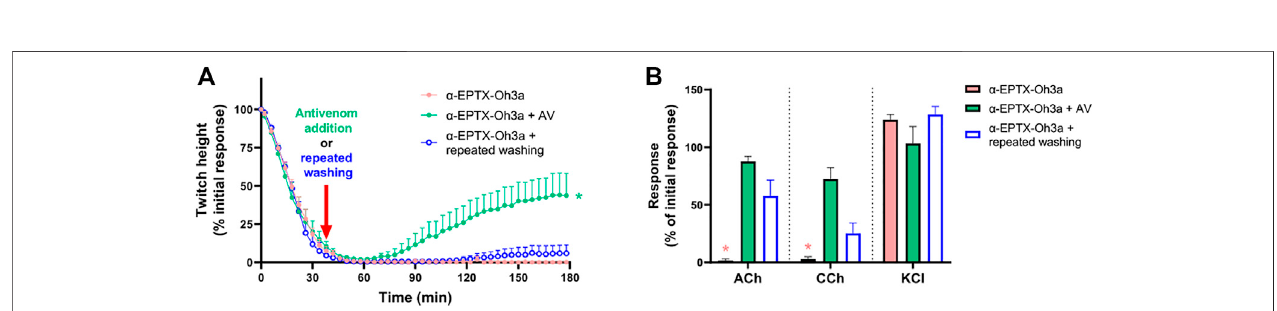
FIGURE 7 | The effect of α -elapitoxin-Oh3a (100 nM) in the absence and presence of Thai Red Cross Society King Cobra antivenom (AV; at the recommended concentration; 1 ml/0.8 mg) or repeated washing of the tissue at the t 90 time point on (A) indirect twitches and (B) responses to exogenous agonists ACh (1 mM), CCh (20 µM) and KCl (40 mM) in the chick biventer cervicis nerve-muscle preparation. * p < 0.05, signi fi cantly different from (A) α -elapitoxin-Oh3a alone at 180 min (one-way ANOVA; n = 4) or (B) pre-toxin response to same agonist (paired t -test, n = 4).